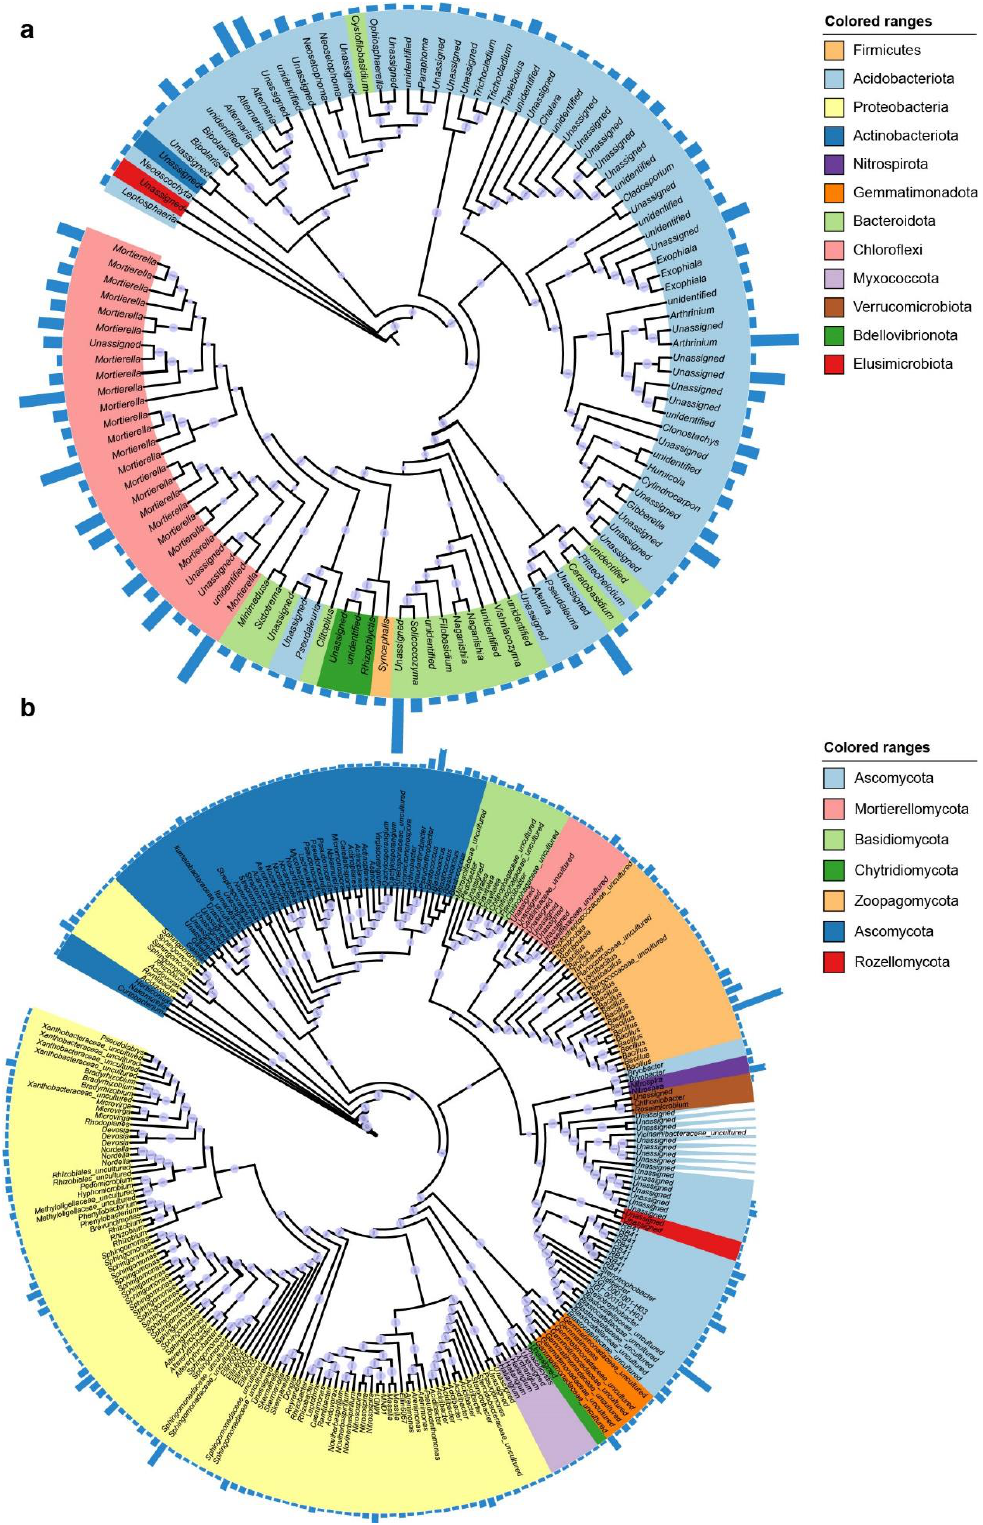
Figure 3. Phylogenetic relationships among core ( a ) bacterial ASVs and ( b ) fungal ASVs (present in >90% of the rhizosphere samples). The blue bar plots (a represent bacteria and b represent fungi) represent the relative abundance of core ASVs. Each node of the phylogenetic tree was colored by the phylum.